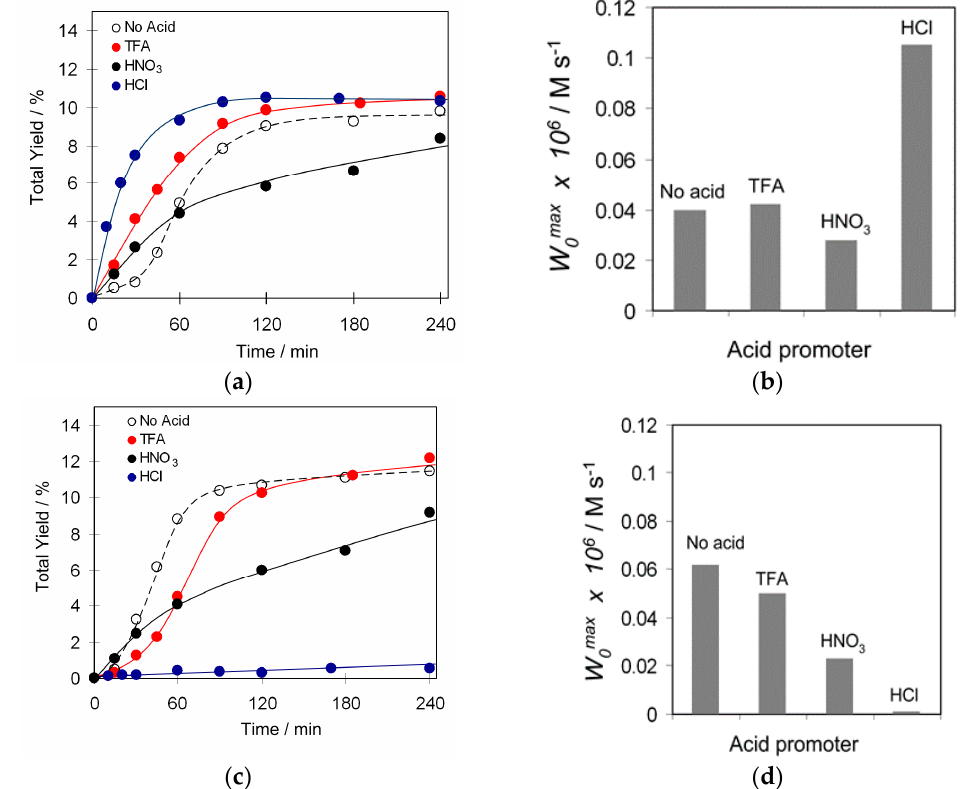
Figure 5. Effect of the acid promoter ( a , c ) on the total yield of cyclohexanol and cyclohexanone and ( b , d ) maximum initial reaction rate ( W 0 ) in the cyclohexane oxidation with H 2 O 2 catalyzed by 1 ( a , b ) and 2 ( c , d ). Reaction conditions are those of Figure 3.